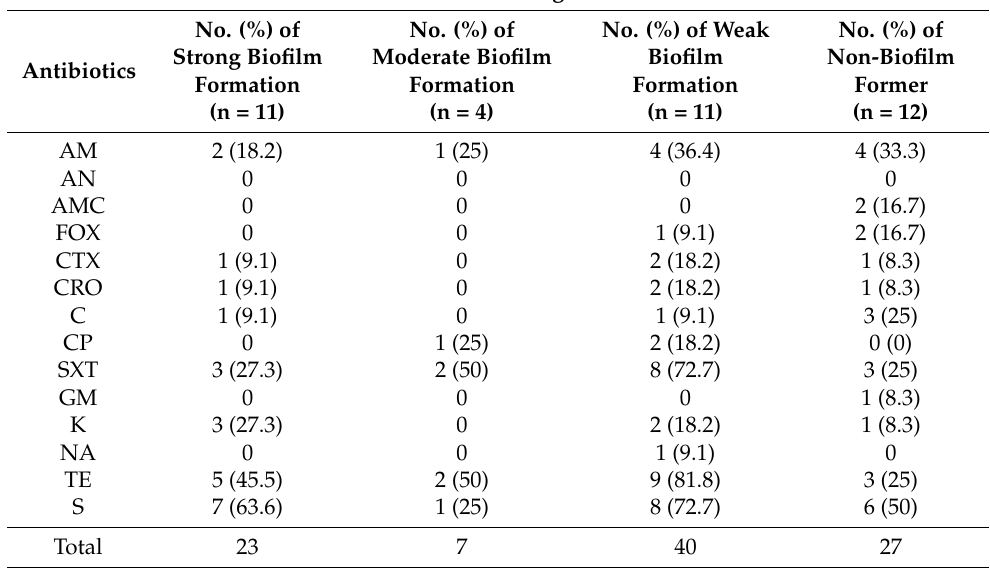
Table 3. Antibiotic resistance patterns of biofilm-producing E. coli strains detected in milk and dairy